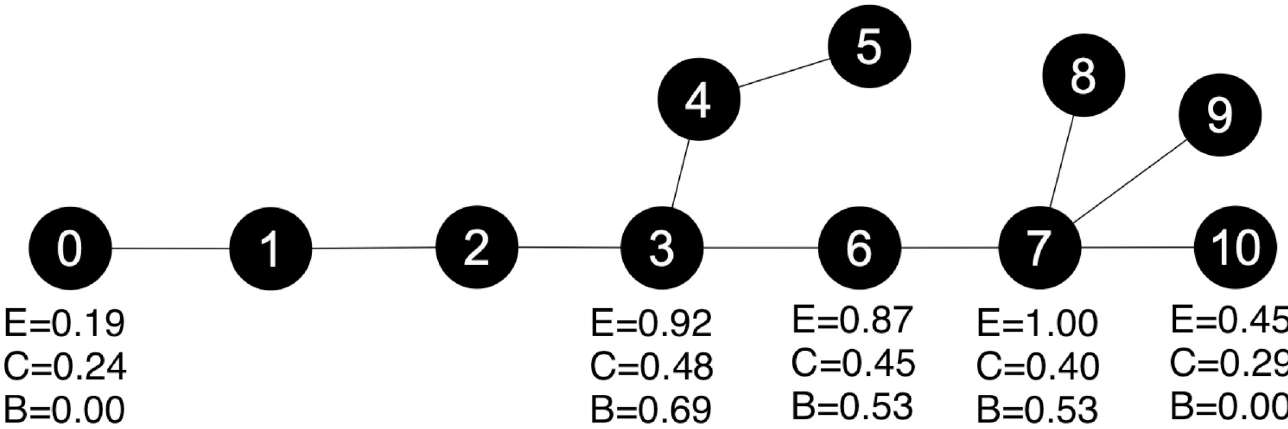
Fig 1. Values for different centrality measures are shown for nodes in a tree. E represents eigenvector centrality, C is closeness centrality, and B is betweenness centrality.